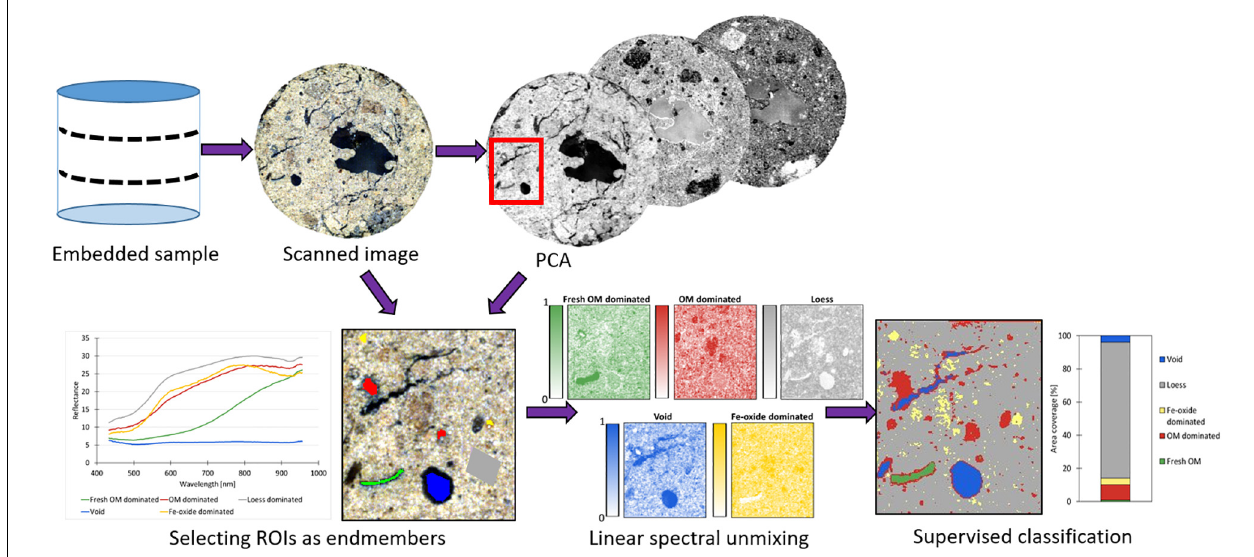
FIGURE 1 | Workflow of imVNIR image processing. After X-ray µ CT analysis, the intact soil cylinders impregnated with polyester resin were cut in two slices of 1 cm thickness. These slices were scanned with a hyperspectral camera. In the first image processing step, scanned images were used to compute a principal component analysis (PCA), which concentrates the spectral information on images and removes correlations between neighboring bands. Principle components were used to separate polyester resin, pores filled with polyester from the soil matrix, and to identify pure spectral endmembers of observed components. In the example of the workflow, we selected five different classes as endmembers (ROI-s) and they were used to calculate relative abundance in each pixel with linear spectral unmixing (LSU). With LSU, abundance maps of each endmember is created, where the most intensive color refers to the highest contribution of selected endmember to the pixel. Obtained abundance maps were subsequently used for a supervised classification using maximum likelihood, and the area coverage of each class can be